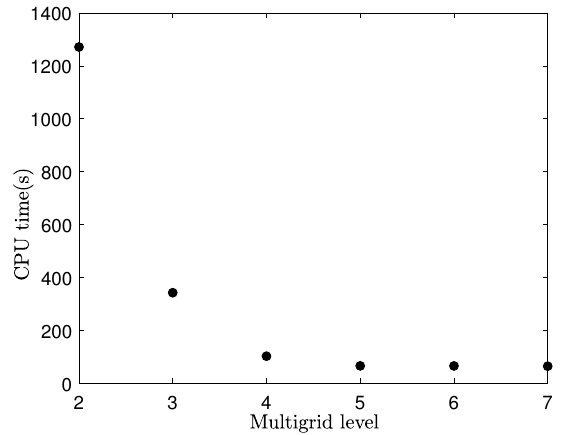
Figure 11. Required CPU times in various multigrid levels after 100 time